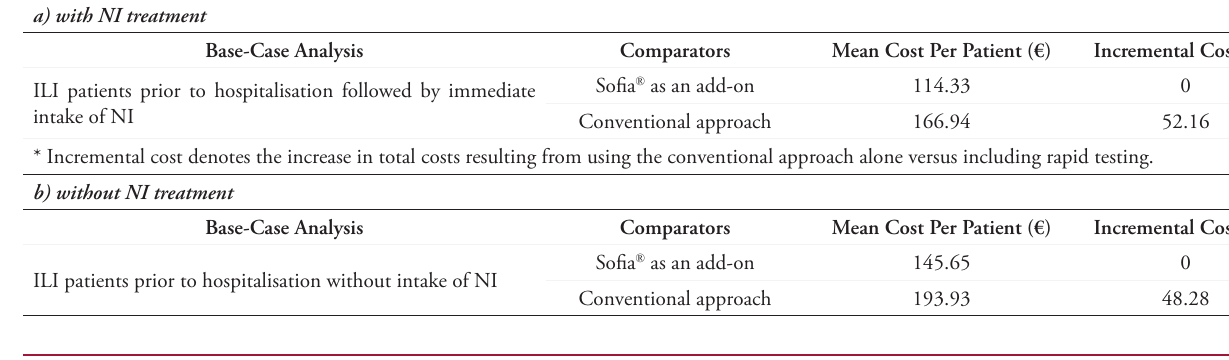
Table 3. Tornado diagram* (rapid POC influenza testing versus the conventional clinical